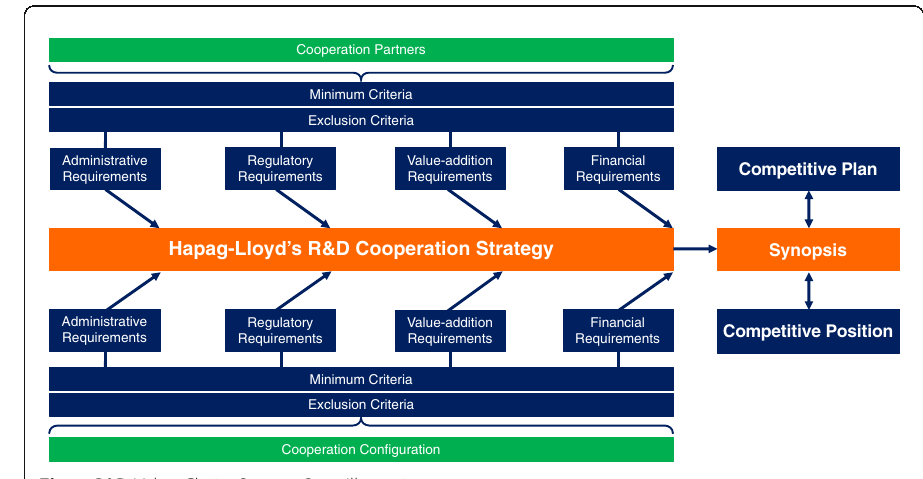
Fig. 5 R&D Value Chain. Source: Own Illustration